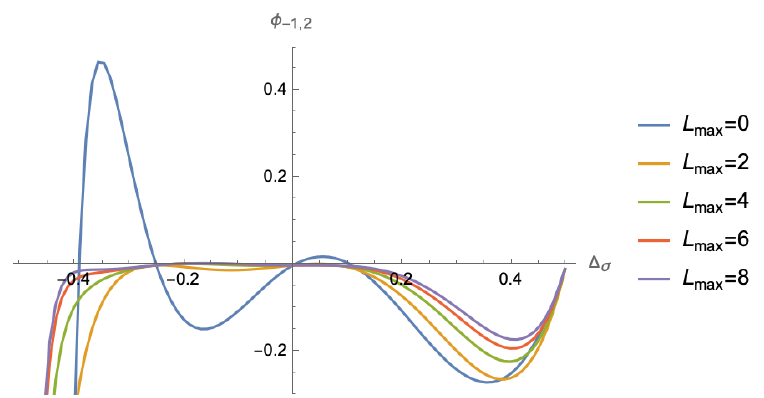
Figure 8: The locality constraint φ −